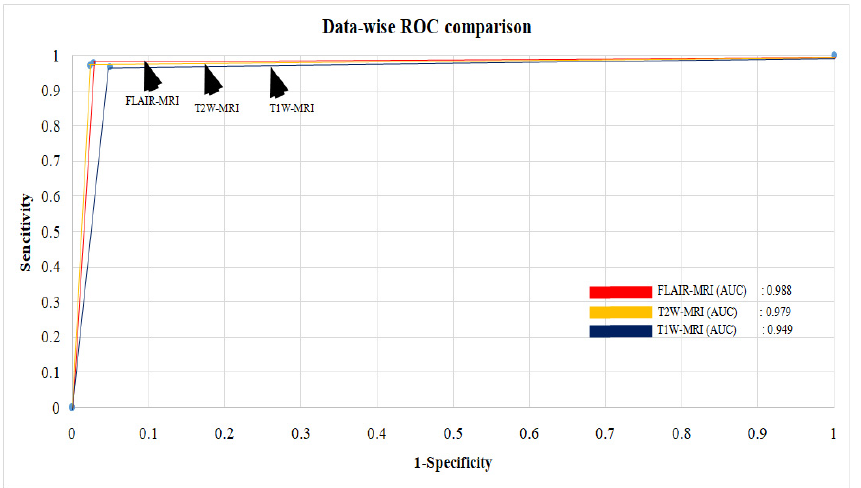
Figure 17. Average ROC between three datasets.